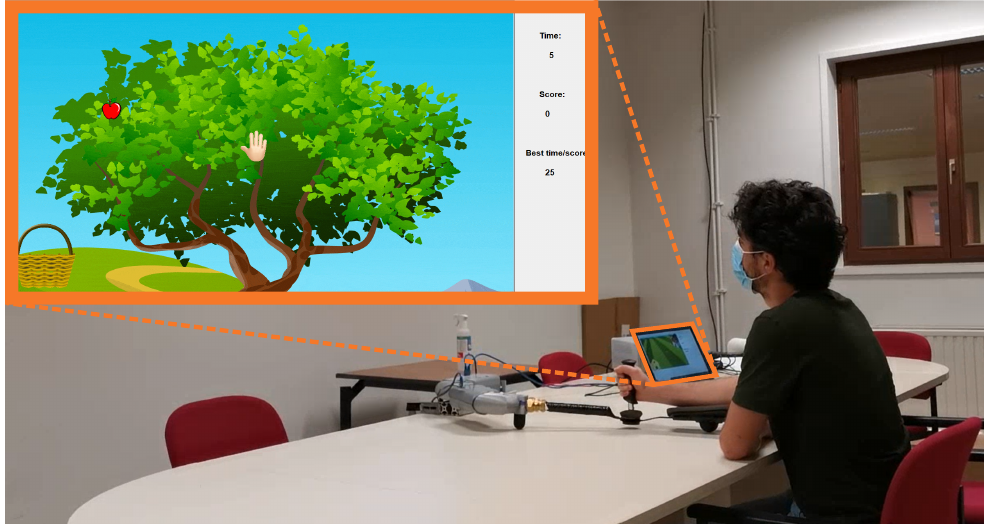
Figure 14. Picture of the upper-body rehabilitation device in use. The user is performing his exercises by playing a game in which he has to pick up apples in a tree and drop them in a basket. The cursor on the computer is controlled by the rotation of the links measured by the encoders inside the SMARCOS. For the sake of clarity, a screen capture of the game is shown in this Figure. During this test, the subject was looking at a projection on a wall, as can be seen in the video of the experiment. The patient can choose among four different gaming scenarios to avoid monotony during the exercise sessions. The objectives of the game are highly adaptable to meet the needs of the user at the different phases of revalidation, as shown in Figure 15. Therefore, the patient can start with basic horizontal or vertical motion training, before moving on to advanced stars and circle patterns. Later on, more complex exercises can be proposed by adding an extra time constraint or by reducing the size of the